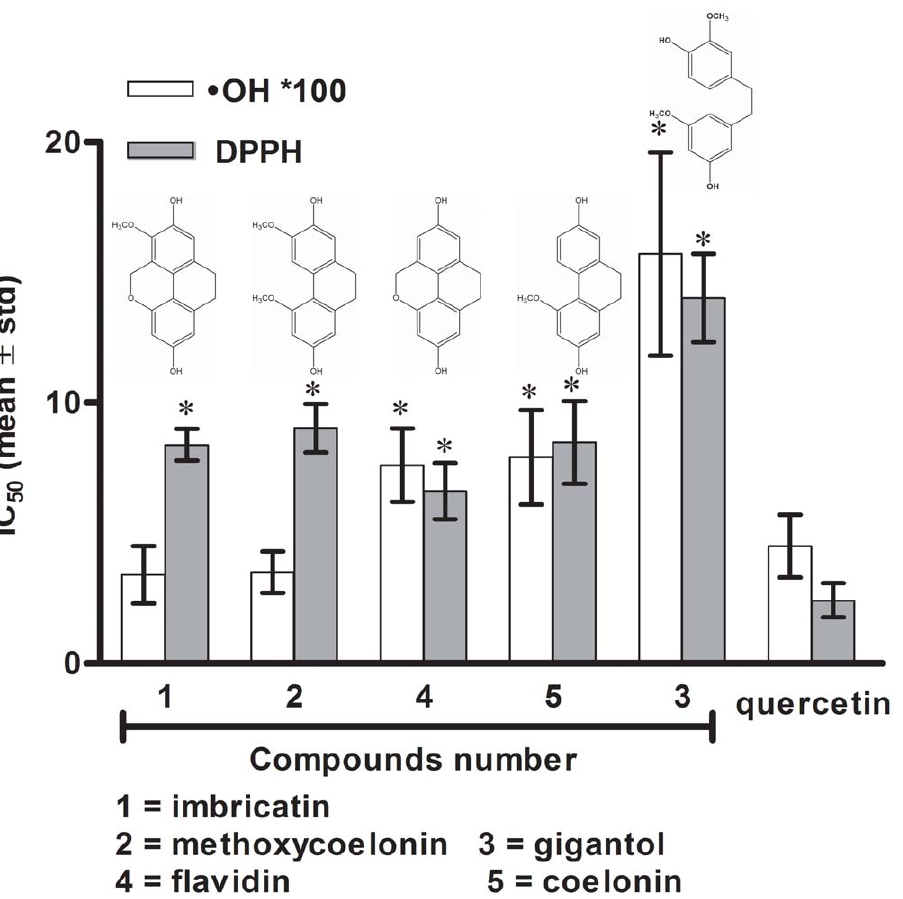
Figure 2. Radical scavenging activities of stilbenoids 1–5 on DPPH and OH radicals. Results are expressed as IC 50 (mean 6 sd) of stilbenoids determined on DPPH and N OH radicals scavenging. IC 50 : concentration causing half-maximal neutralization of radical DPPH or N OH. Quercetin was used as standard reference. IC 50 values were compared to those obtained with the standard reference. Statistical significance (*) was set at p , 0.05.